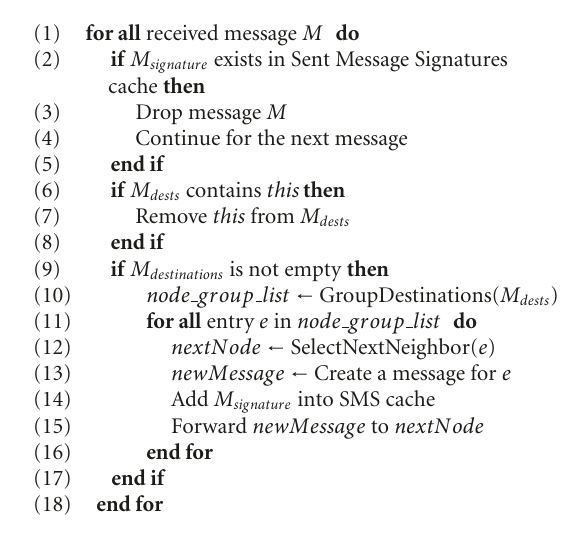
Algorithm 4: Location-Based Multicasting with Direction.